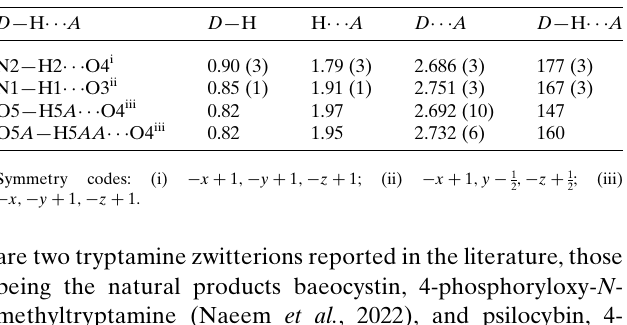
Table 1 Hydrogen-bond geometry (A˚ , (cid:3) ) for the methanol solvate.